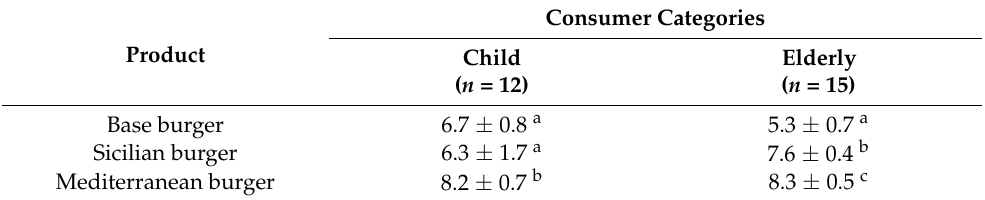
Different superscript letters in the same column indicate significantly different values ( p < 0.05 by post hoc Tukey’s HSD test); the same superscript letters in the same column indicate not significantly different values ( p > 0.05